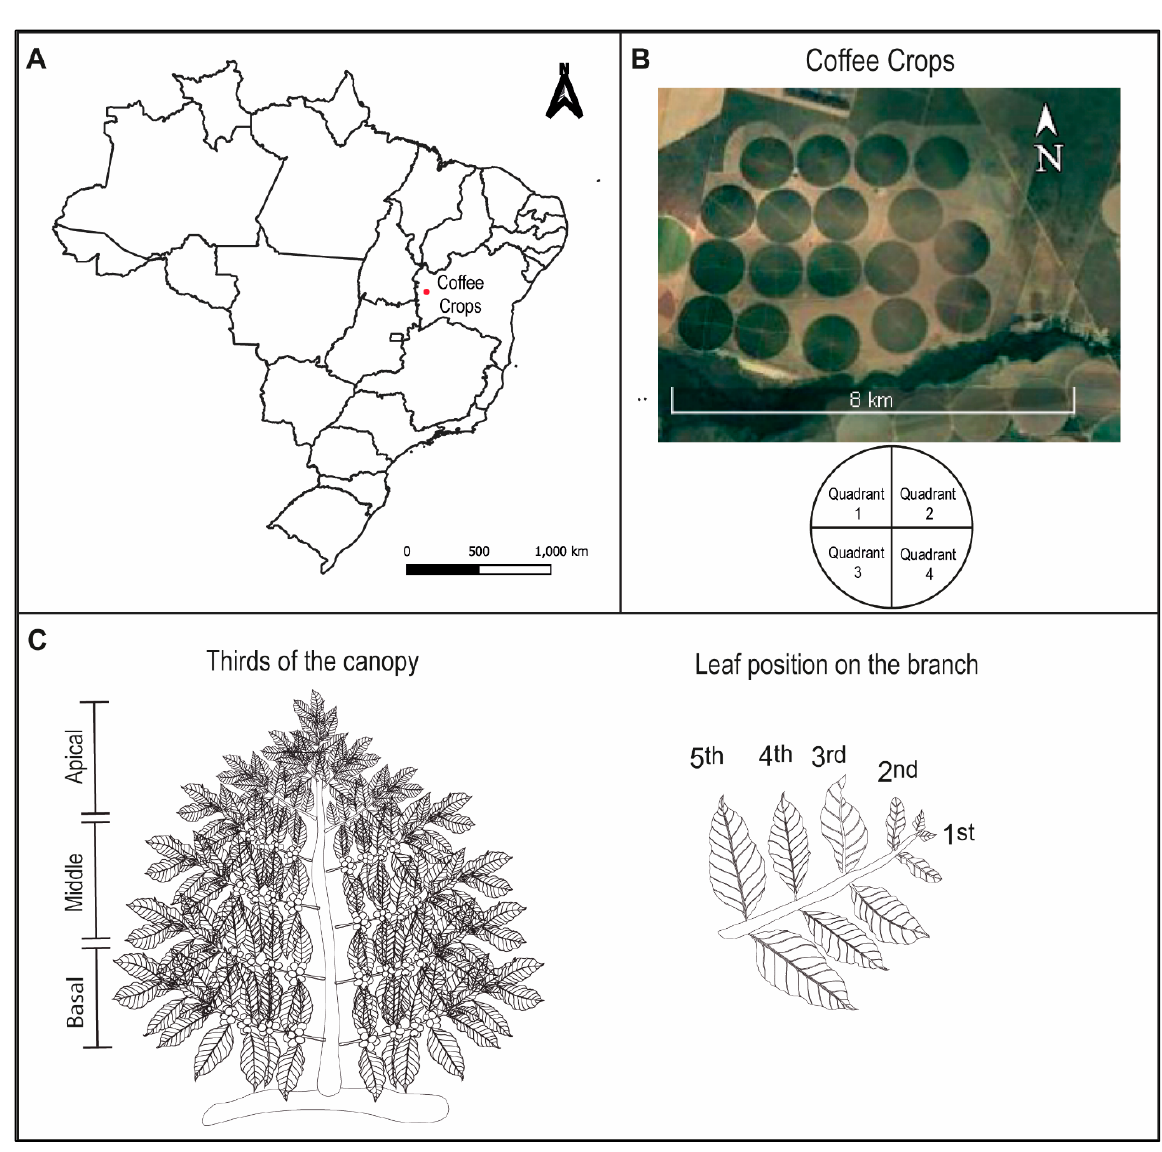
Figure 1. Location of coffee crops and leaf position evaluated in sampling. ( A ) Milan Farm location in Brazil; ( B ) pivot quadrants; and ( C ) leaf position where the attack of Leucoptera coffeella was evaluated in the thirds of the canopy and in the branches.